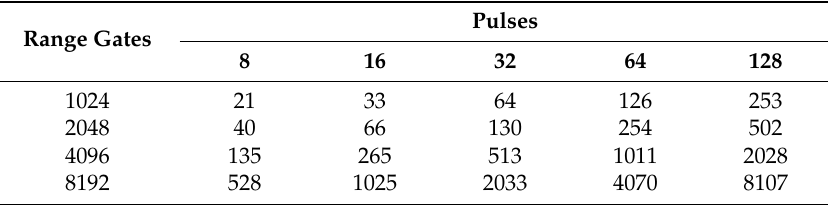
Table 4. Time consumption measured in µ s of corner turn for one beam.